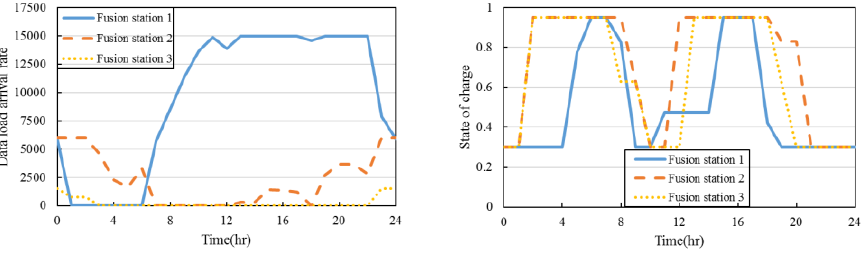
Fig. 3. Workload distribution in scenario B. Fig. 4. Real-time operation of ESPS in scenario B.